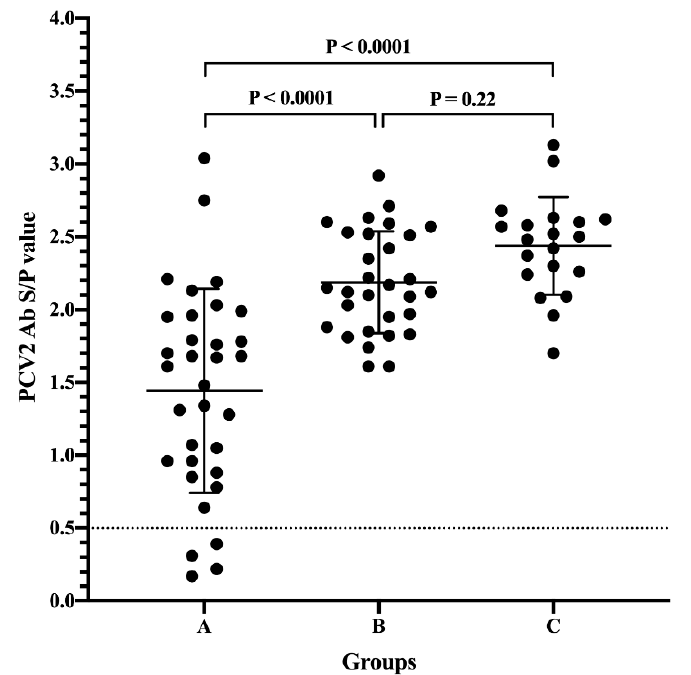
Figure 1. Comparison of maternally derived antibodies (MDA) of porcine circovirus type 2 (PCV2) on suckling piglets (only from 3 to 4-week-old piglets without PCV2 vaccination) born from different sow immunization programs against PCV2. A: sows without PCV2 vaccination; B: sows with